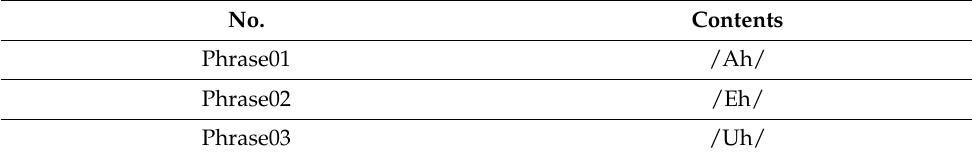
Table 5. Phrases used for the voice